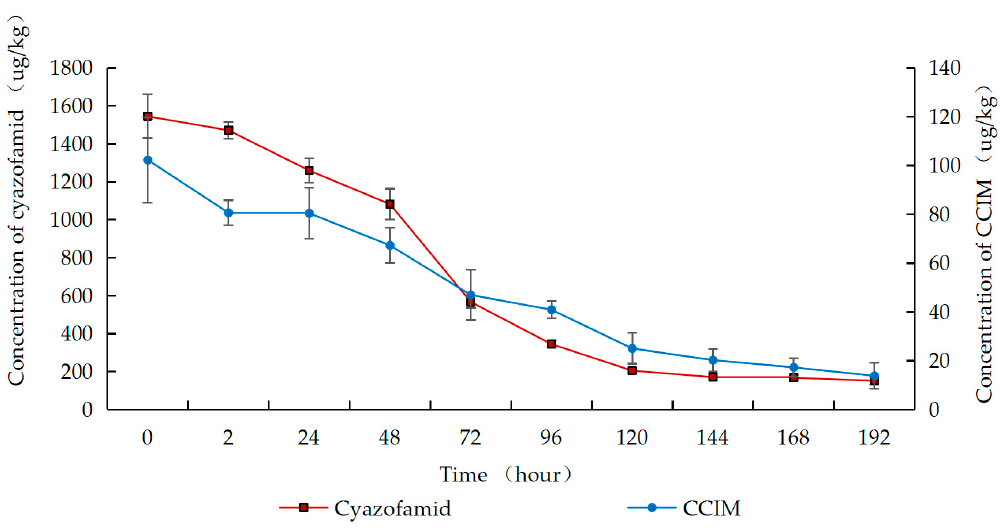
Figure 3. Concentrations of cyazofamid and CCIM in Group B during the wine-making process.